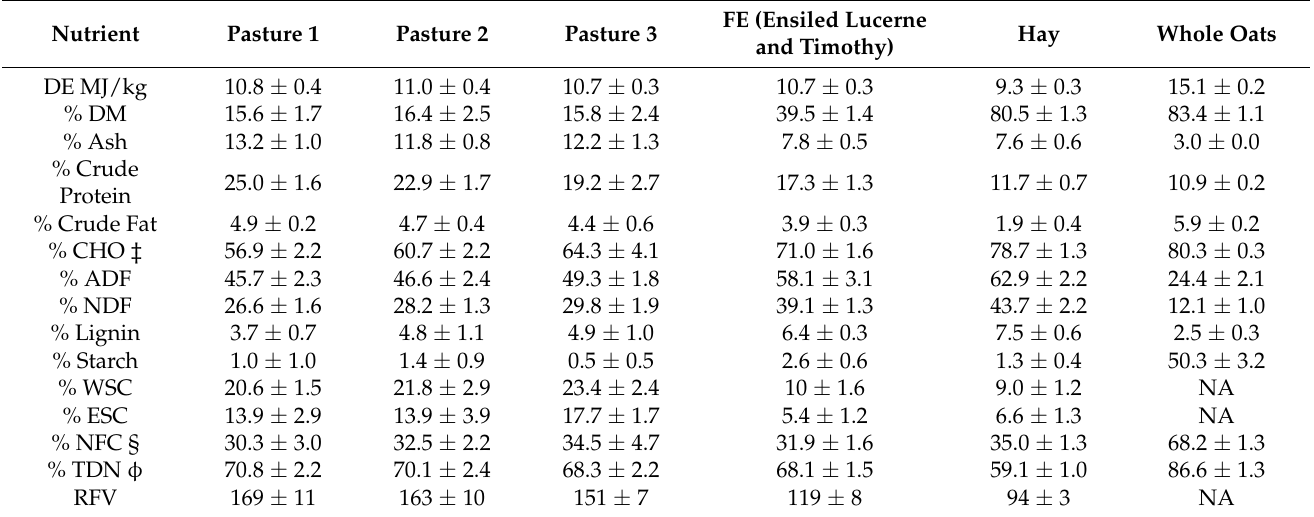
Table 1. Nutrient analysis (on a DM basis) of dietary components used in the